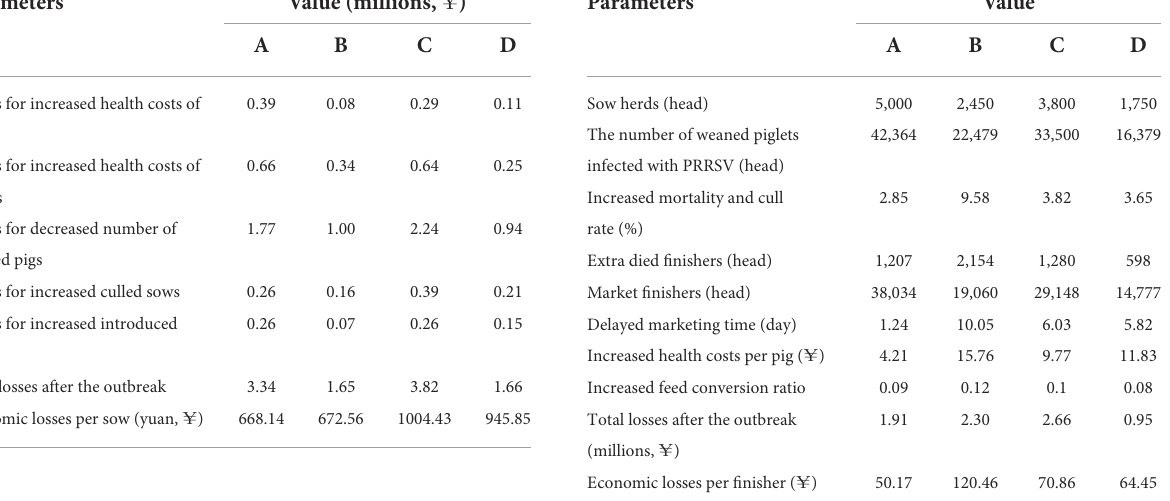
TABLE 3 The main economic parameters and economic losses (millions, U ) after the PRRS outbreak in the fattening herds. Parameters